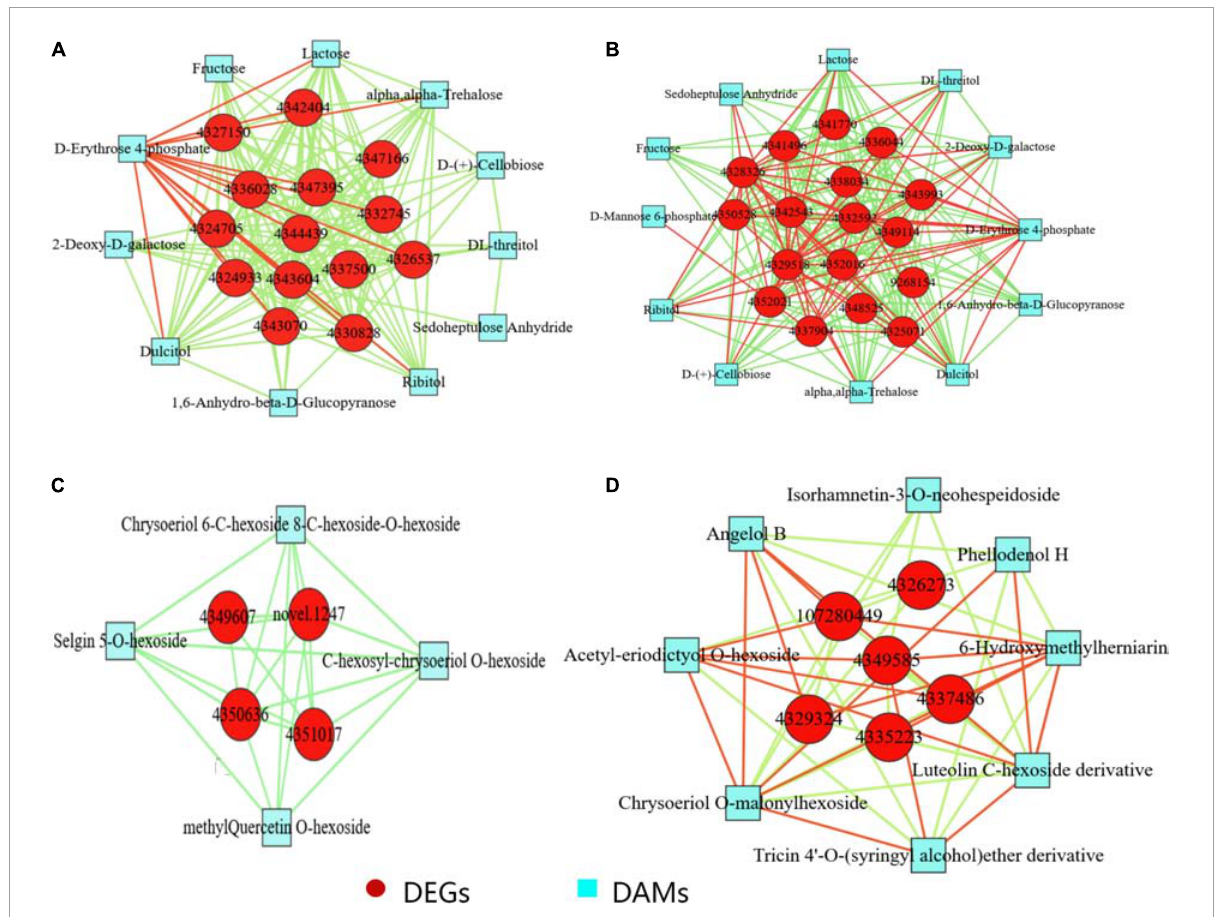
FIGURE4 Co-expression analysis of DEGs and DAMs based on Pearson correlation coefficient. Interaction network of DEGs and DAMs involved in (A) photosynthesis in DSL vs. DL, 4326537, 4324933, 4337500, 4332745, 4327150, photosystem II gene; 4344439 ferredoxin gene; 4342404, 4347395, 4343070, 4330828, 4347166, photosystem I genes; 4343604, 4336028, 4324705, chlorophyll a-b binding protein. (B) Carbon metabolism in DSL vs. DL, 4329518, acetyl-coenzyme A synthetase; 4343993, malate dehydrogenase chloroplastic; 4325071, 4341770, fructose-bisphosphatase; 4341496, fructose-bisphosphate aldolase; 4350528, 6-phosphogluconate dehydrogenase; 4352021, 4328326, 4352016, ribulose bisphosphate carboxylase; 4342543, ribose-5-phosphate isomerase 4332592, acetate/butyrate–CoA ligase 4337904, acyl-coenzyme A oxidase; 4336044, glyceraldehyde-3-phosphate dehydrogenase; 9268154, malate synthase; 4349114, glycine cleavage system; 4348525, alanine aminotransferase 2; 4338034, 6-phosphofructokinase. (C) Flavonoid biosynthesis in DSL vs. DL, 4350636, novel.1247, chalcone synthase 1; 4349607, 4351017, chalcone–flavanone isomerase 3. (D) Flavonoid biosynthesis in DSR vs. DR. 4335223, cinnamyl alcohol dehydrogenase 6; 4349585, 4337486, cationic peroxidase; 4329324, cytochrome P450 CYP73A100; 107280449, 4326273, peroxidase. Red circles indicate differential genes, and blue squares indicate differential metabolites; Edges colored in “red” and “green” represent positive and negative correlations, respectively, based on Pearson correlation coefficient > 0.8 and < –0.8,